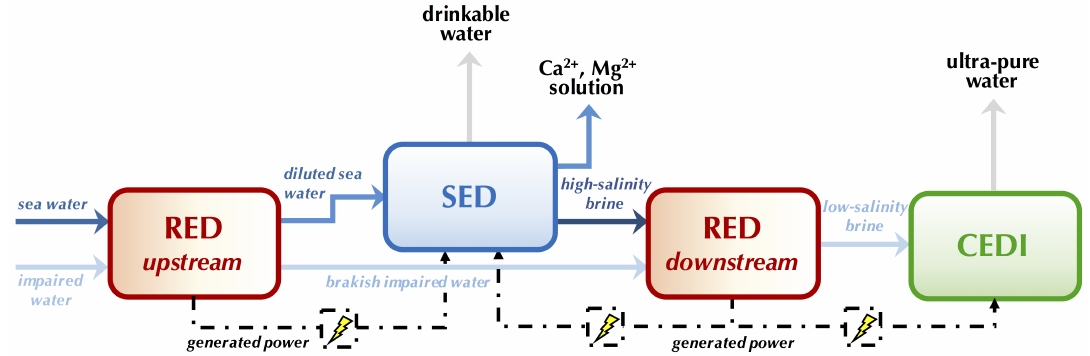
Figure 24. Theoretical PFED strategy (adapted from Campione et al. [10]). RED: reverse electrodialysis; SED: selectrodialysis; CEDI: continuous